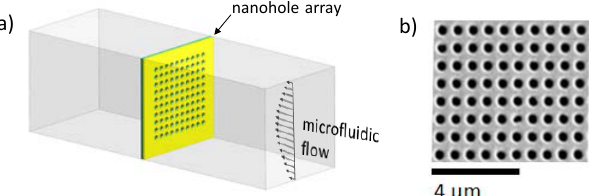
Figure 1. ( a ) SEM image of fabricated periodic subwavelength apertures via focused ion beam (FIB). The nanostructures were 230 nm in diameter and 560 nm in pitch. ( b ) Schematic representation of a nanohole array in a microfluidic chip in flow-through operation.